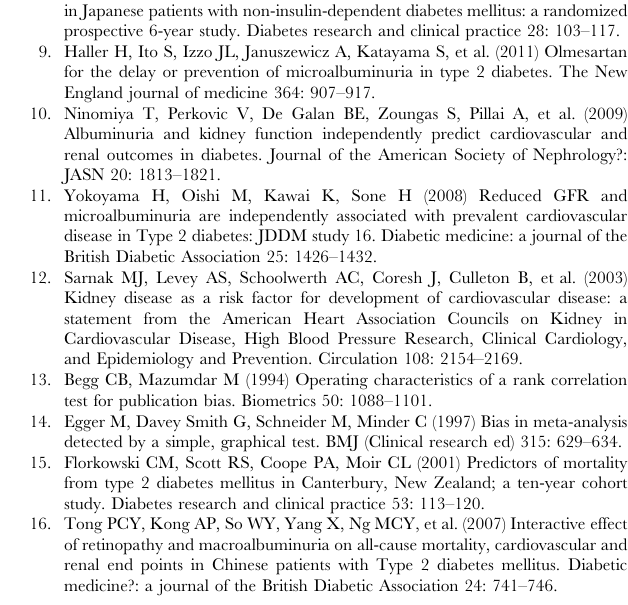
Figure S1 Subgroup analysis for examination of poten- tial sources of heterogeneity in the association between micro- or macroalbuminuria and cardiovascular mor- tality, all-cause mortality or renal events. Figure S2 Age stratified analysis for the association between albuminuria and cardiovascular mortality, all- cause mortality, and renal events compared with